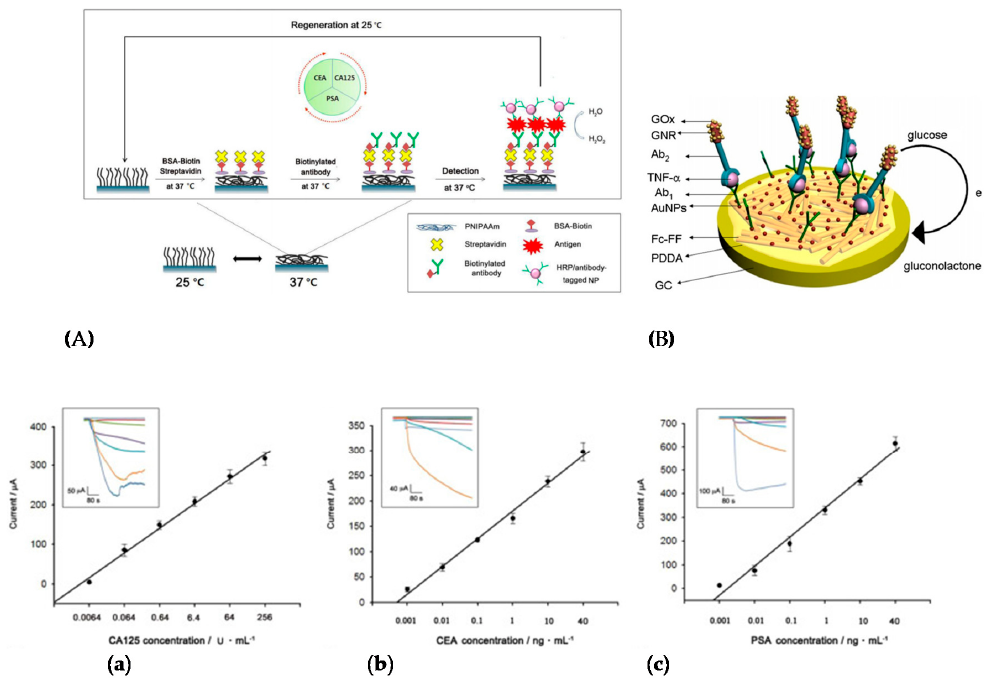
Figure 20. ( A ) PNIPAAm-based immunosensor for CA125, CEA and PSA detection; ( a – c ) Electrochemical response of this sensor to CA125, CEA, and PSA, respectively. Chronoamperometric results were obtained at − 0.2 V. After incubation with the target proteins, HRP/antibody-tagged PPy NPs were bound to the primary antibody on the PNIPAAm-Au, and 0.1 M hydroquinone and 0.5 mM H 2 O 2 were addede in PBS buffer. Reprinted from [107], Copyright 2016, with permission from Elsevier; ( B ) GOx-modified gold nanorods for TNF- α detection. Reprinted from [111], Copyright 2013, with permission from Elsevier.